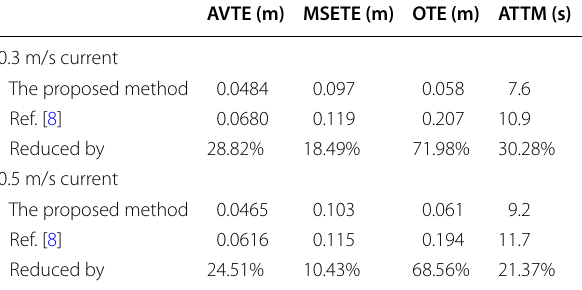
Table 6 Experimental data in different ocean current environments